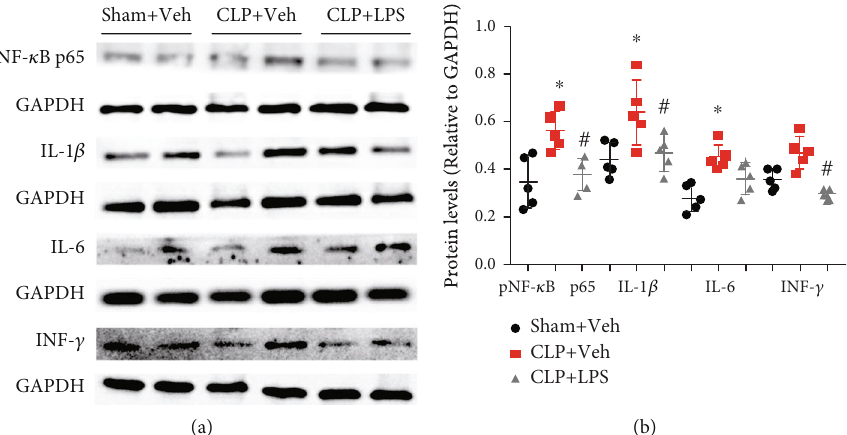
Figure 6: E ff ects of repeated LPS injections and CLP on hippocampal in fl ammatory mediators. There were signi fi cantly increased hippocampal pNF- κ B p65, IL-1 β , and IL-6 levels following CLP. However, repeated LPS injections were able to prevent the increased pNF- κ B p65 and IL-1 β levels. Data represent mean ± SEM ; n = 5 /group. ∗ P < 0 : 05 vs. sham + Veh group; # P < 0 : 05 vs. CLP+Veh group. LPS: lipopolysaccharide; CLP: cecal ligation and puncture; Veh: